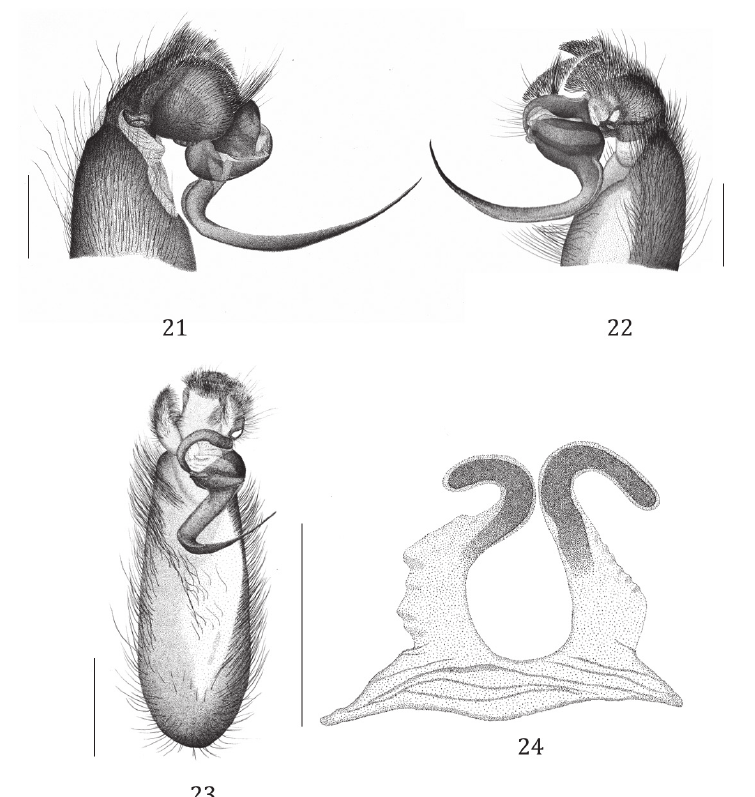
Figures 21–24. Phlogiellus longipalpus sp. n. 21 holotype ♂ , CUMZ-C2-NA1, left pedipalp, prolateral view 22 same, retrolateral view 23 same, ventral view 24 CUMZ-C4-NA4, spermathecae, dorsal view. Scale bars 1 mm ( 21–24